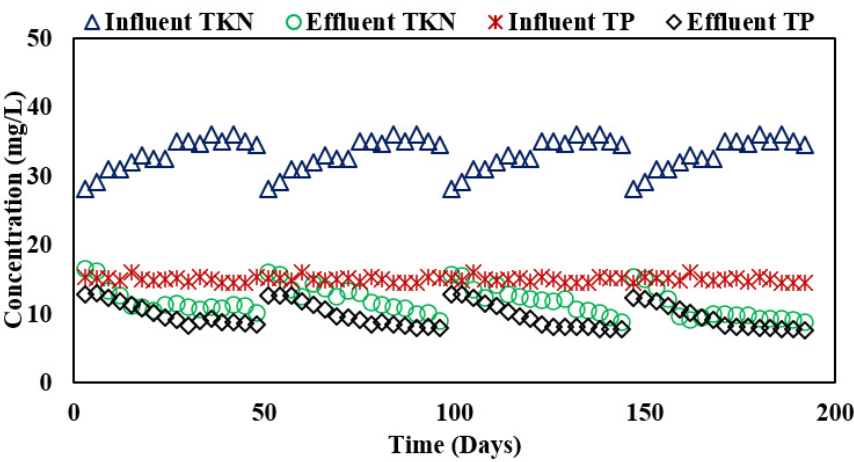
Figure 3. Influent and effluent TKN and TP concentrations in ABR-AF system during Phase